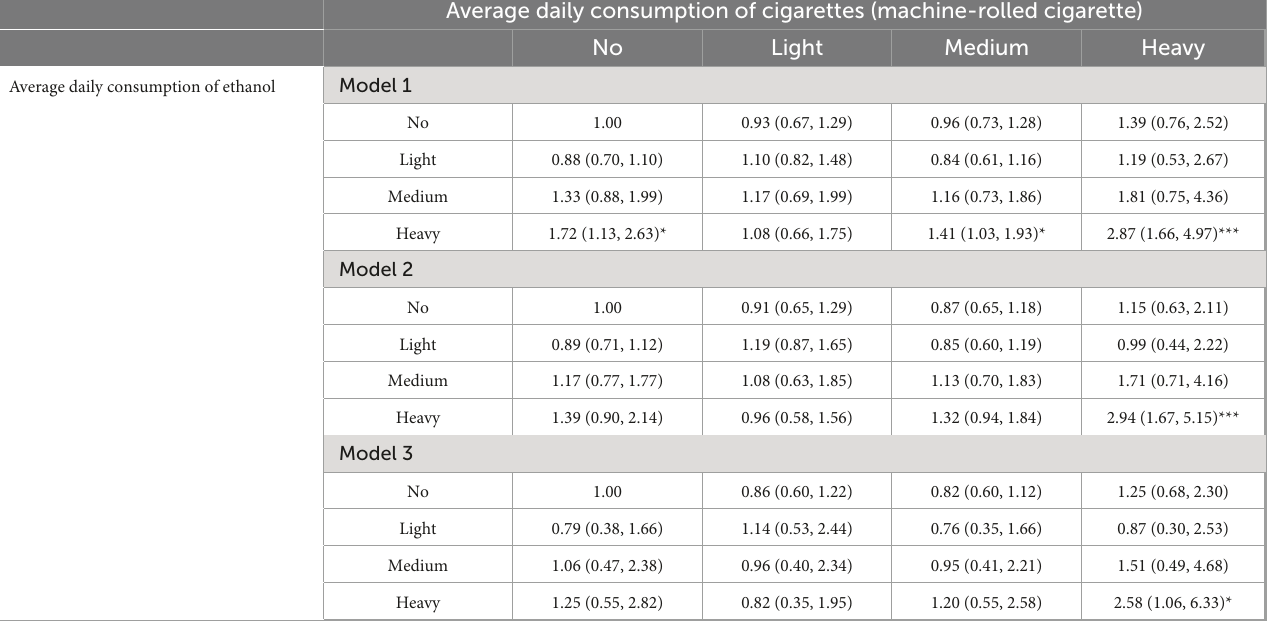
TABLE 4 Hazard ratios (95% confidence intervals) of hypertension associated with smoking and alcohol consumption. Average daily consumption of cigarettes (machine-rolled cigarette) No